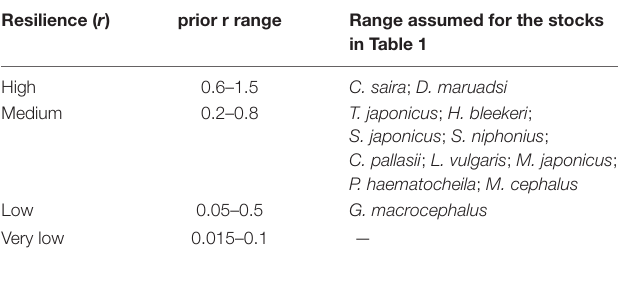
TABLE 2 | Ranges suggested by FishBase (www.fishbase.org) for population growth rate (year − 1 ). Resilience ( r